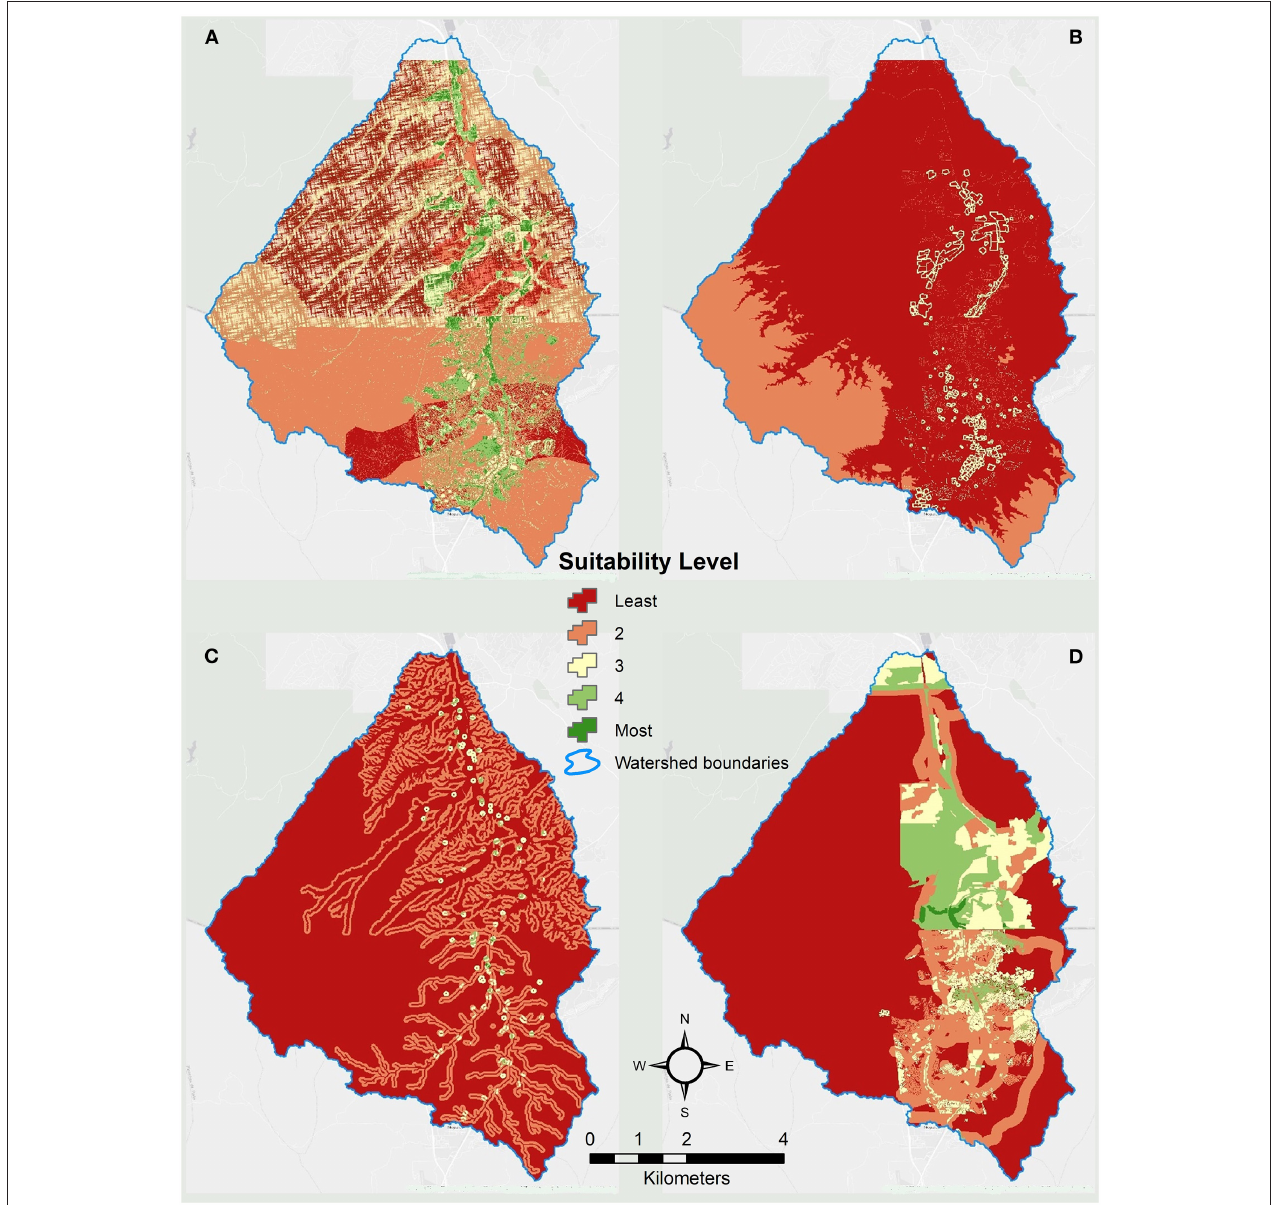
FIGURE 3 | Composite maps showing locational distribution of factors interacting with (A) UGI effectiveness. (B) UGI flooding mitigation potential. (C) UGI water quality protection. (D) UGI greenspace